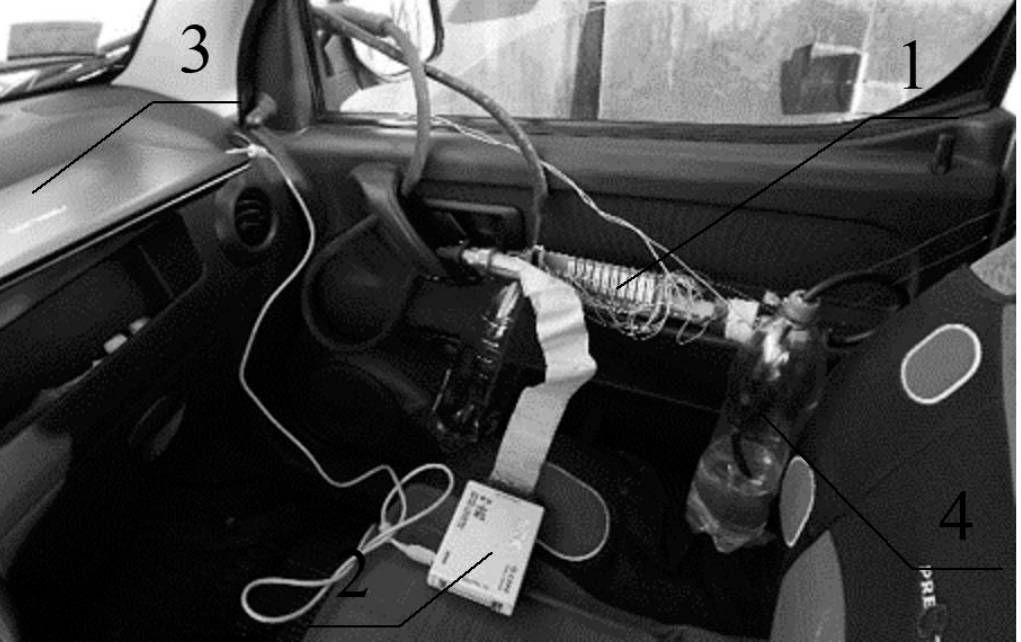
Figure 4. Carrying out experimental studies on the vehicle: 1, flowmeter; 2, analog–digital converter; 3, computer; 4, vessel with fuel.